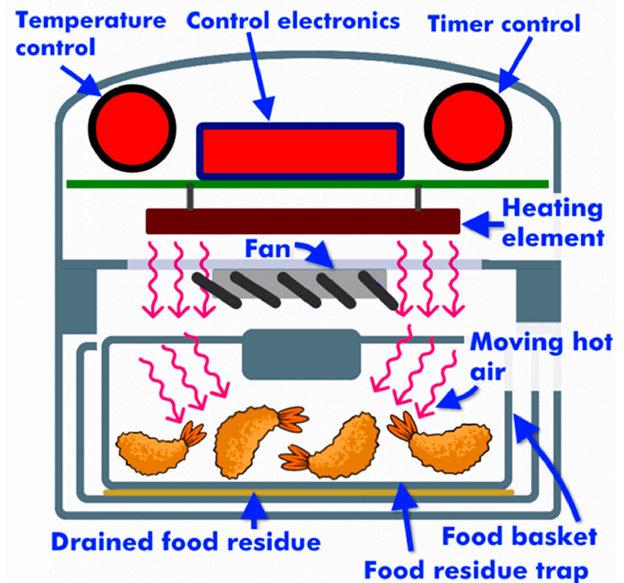
Figure 3. A schematic diagram of air frying equipment, which shows how an air fryer works and the main sections inside [96].